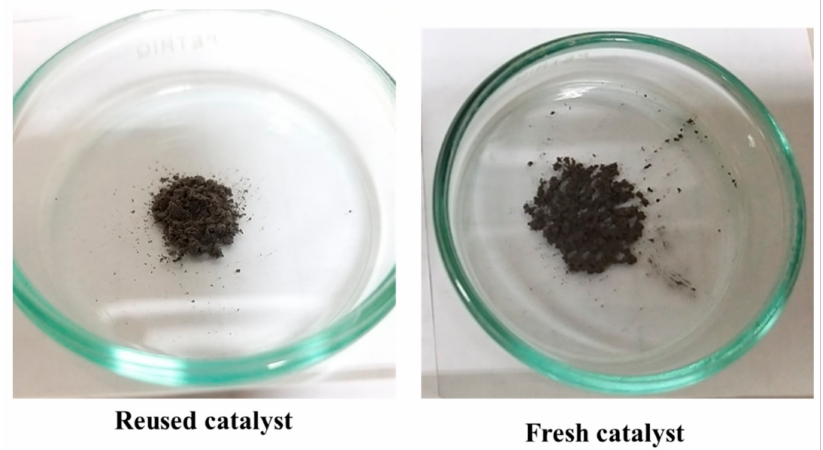
Figure 13. Comparison of the color of the fresh and reused